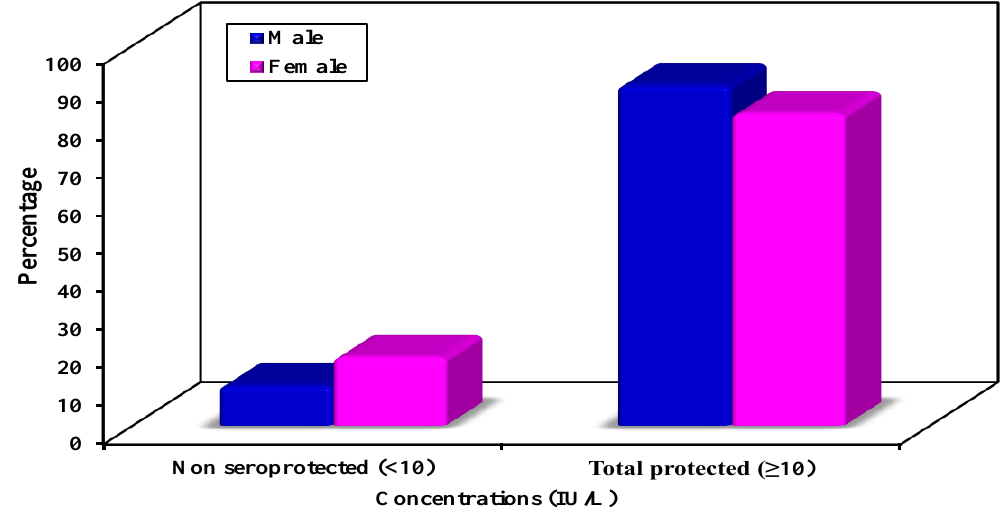
Figure 1. Comparison between Male and Female genders according to anti-HBs concentrations.